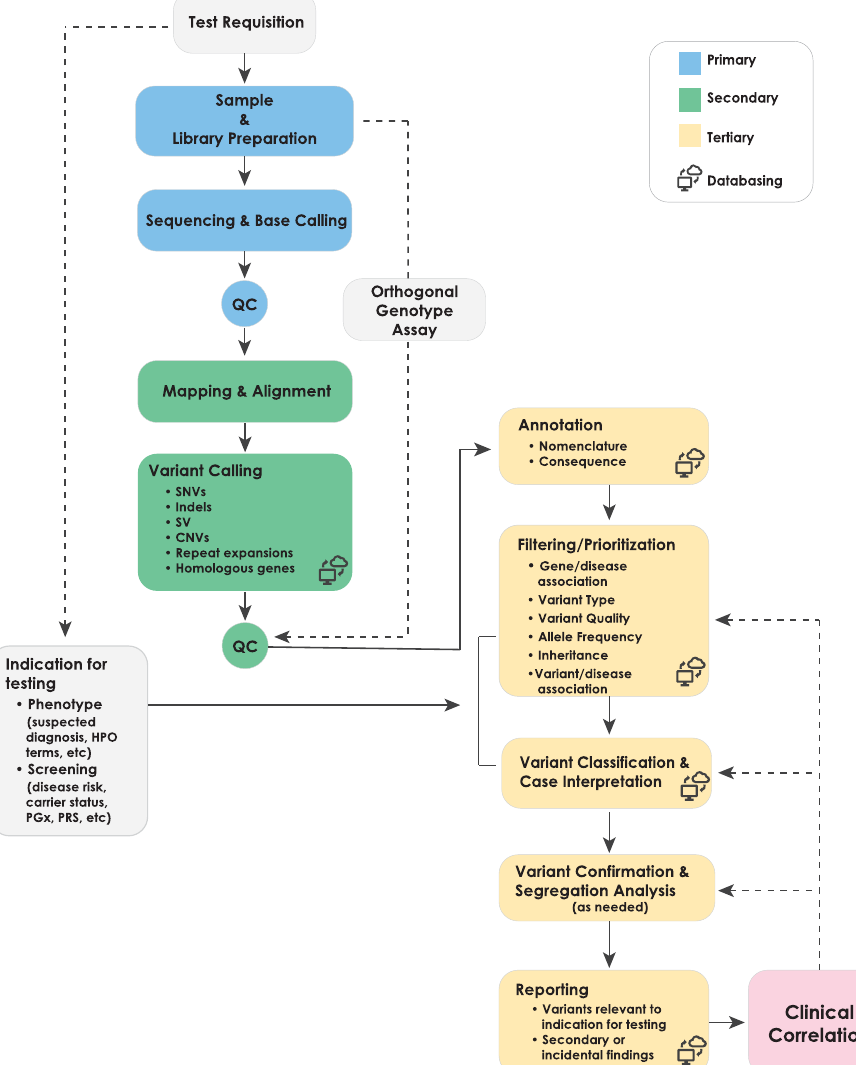
Fig. 1 Clinical Whole Genome Sequencing Work fl ow. Primary WGS analysis (blue) refers to the technical production of DNA sequence data from biological samples through the process of converting raw sequencing instrument signals into nucleotides and sequence reads; secondary analysis (green) refers to the identi fi cation of DNA variants through read alignment and variant calling; and tertiary analysis (yellow) refers to adding context through variant annotation and the subsequent informatics-driven fi ltering, triaging, and classi fi cation of variants. Tertiary analysis also includes case interpretation, variant con fi rmation, segregation analysis, and reporting. While case interpretation is integrated into the laboratory process, it is important to note that clinical correlation on the part of the ordering provider is a key fi nal step in the process and may inform additional tertiary analysis steps. Figure originally published in Marshall et al. 2020 17